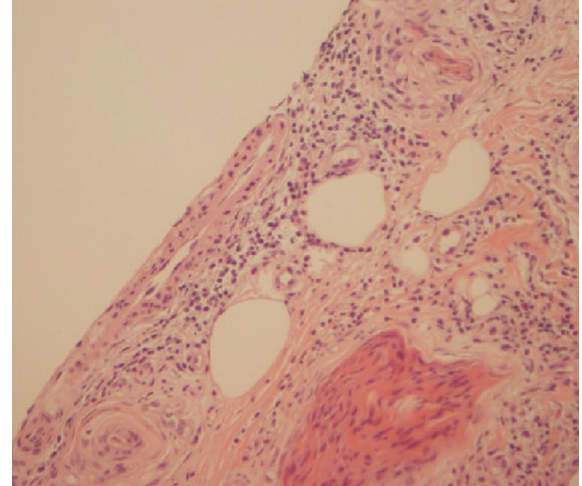
Figure 2: A sural nerve biopsy showing subcutaneous vessels with leukocytoclasis, fibrinoid necrosis, and a perivascular lymphocytic infiltrate